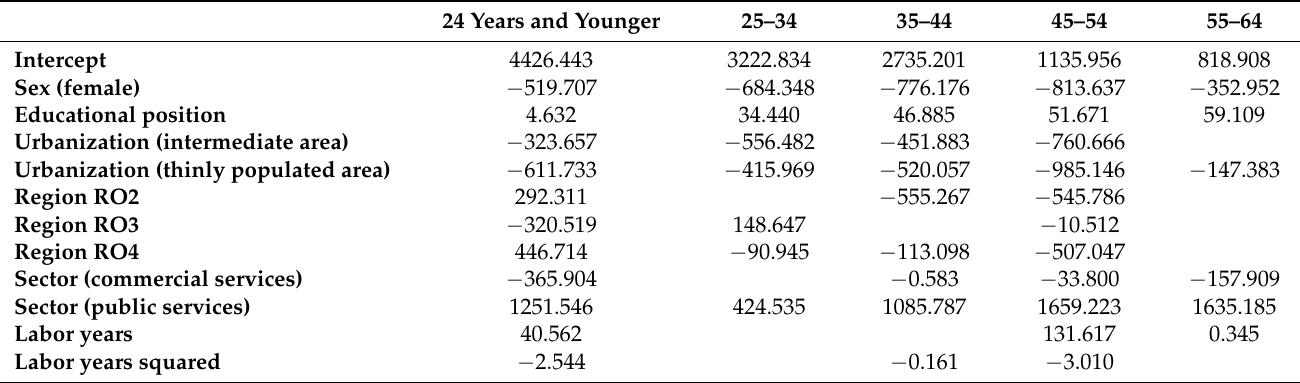
Table A2. Coefficients for model 2 using the relative measure of